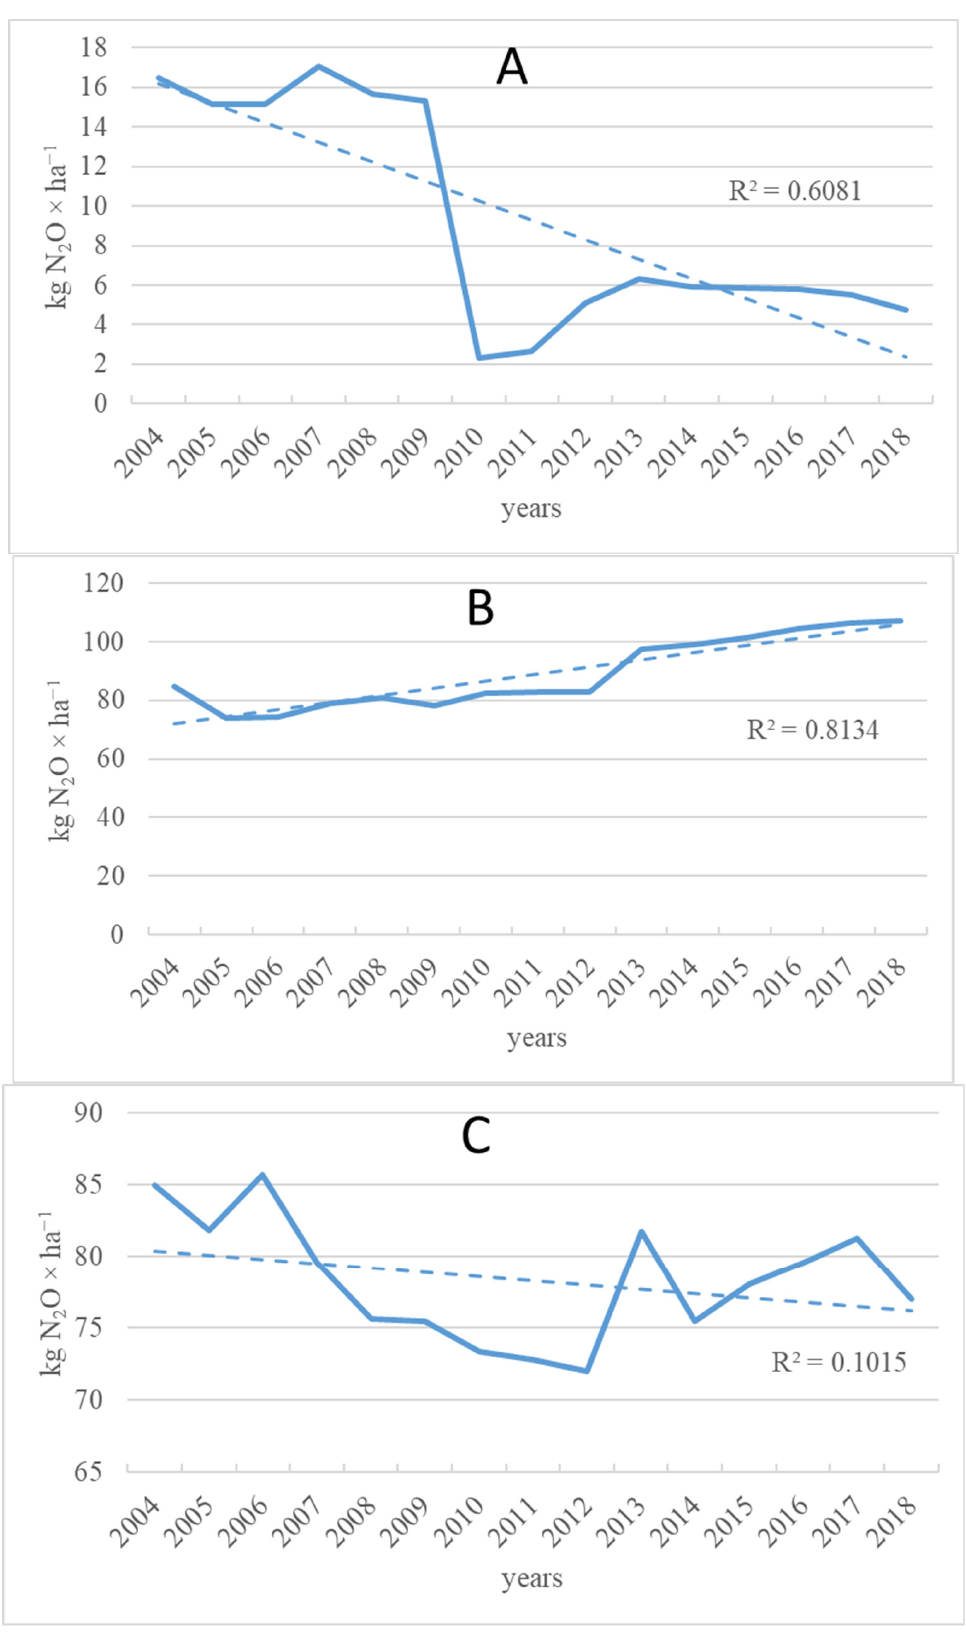
Figure 2. Emission levels of N 2 O (kg·ha − 1) at different types of farms: ( A ) Field crops; ( B ) Milk; ( C ) Mixed. Farms that specialize in milk production produce the most nitrous oxide emissions, taking into account nitrous oxide from animal feces and mineral fertilization at a level of 90.06 kg N 2 O ha − 1 (Figure 2B). Meanwhile, on mixed farms, the value of nitrous oxide emissions was 78.96 kg N 2 O·ha − 1 , and on farms specializing in field crops it was 9.65 kg